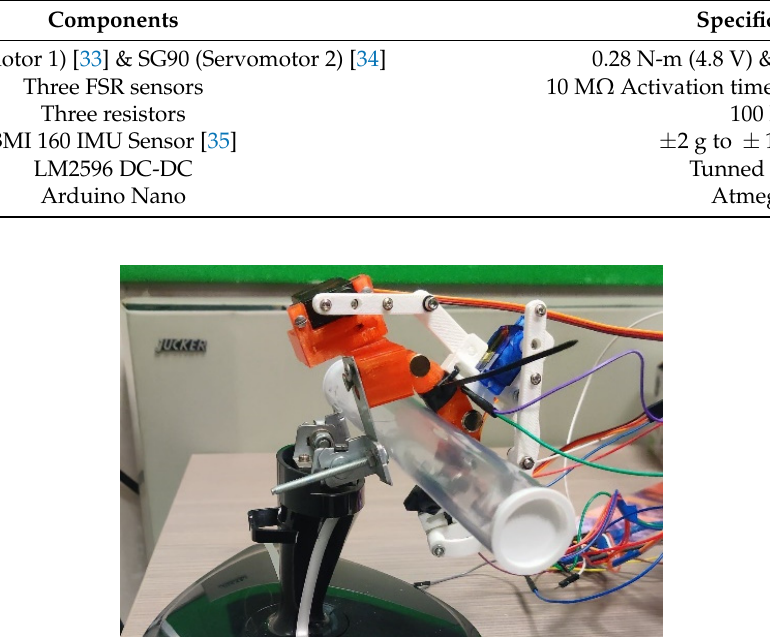
Table 2. Design parameters and dimensions of the proposed finger exoskeleton [28].